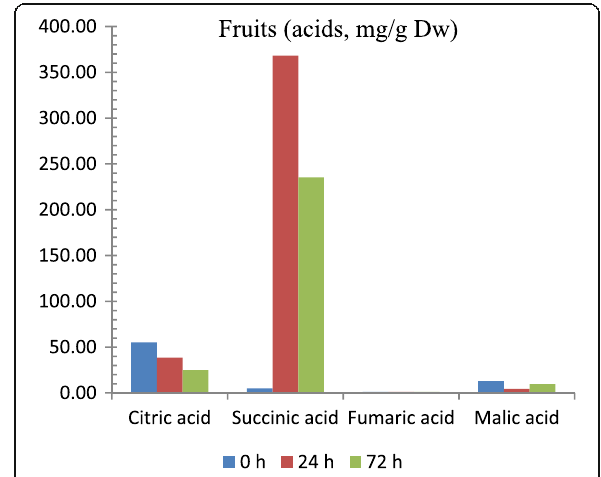
Fig. 4 Average values of organic acids in all the analyzed